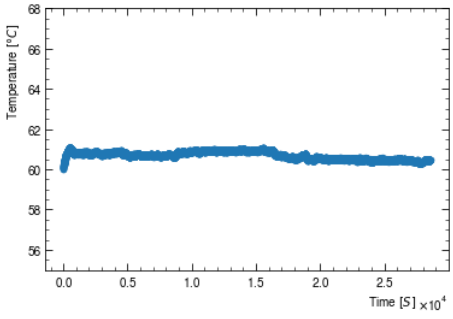
Figure 8. Temperature stability plot of a V8.4.2 Brick undergoing burn-in